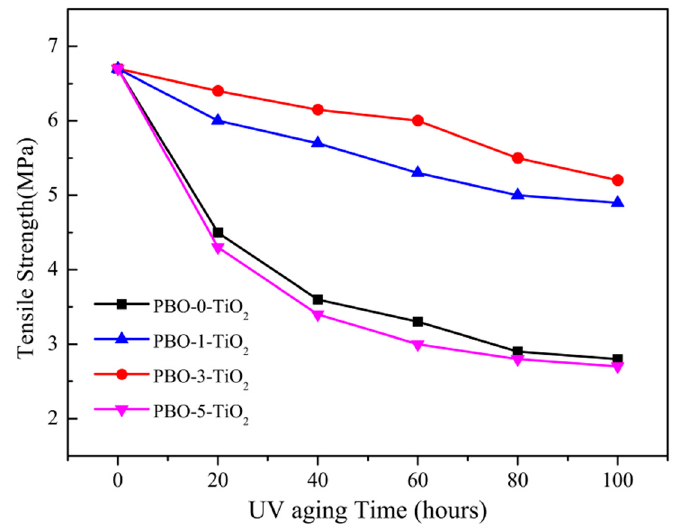
Figure 8. Tensile strength of the PBO fibers after UV aging for different times.